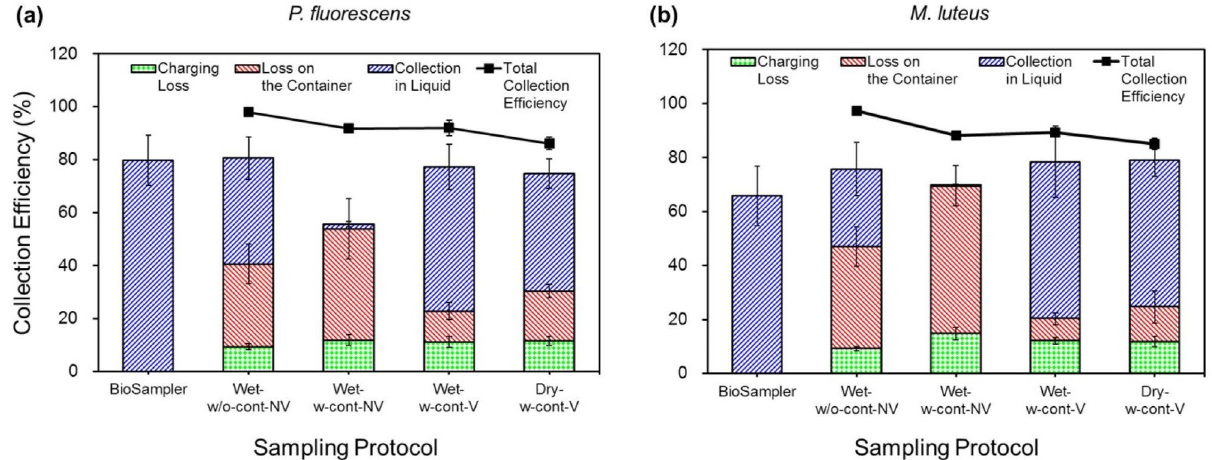
Figure 2. Collection efficiencies of ( a ) P. fluorescens and ( b ) M. luteus in the EPC (− 5 kV) using different sampling protocols and in the BioSampler with a sampling medium of 1 × phosphate buffered saline. The total collection efficiencies were compared with the fractions of bacterial cells remaining in the EPC when four different sampling protocols were used. The Loss on the Container in case of Wet-w/o-cont-NV indicates the particle losses attached to a thin polyimide film. Wet-w-cont-NV (Wet sampling with a container, but no vortexing after the sampling), Wet-w-cont-V (Wet sampling with a container and subsequent vortexing after the sampling), Wet-w/o-cont-NV (Wet sampling on a polyimide film of the EPC electrode with no vortexing afterwards), and Dry-w-cont-V (Dry sampling with a container and subsequent vortexing after buffer addition).